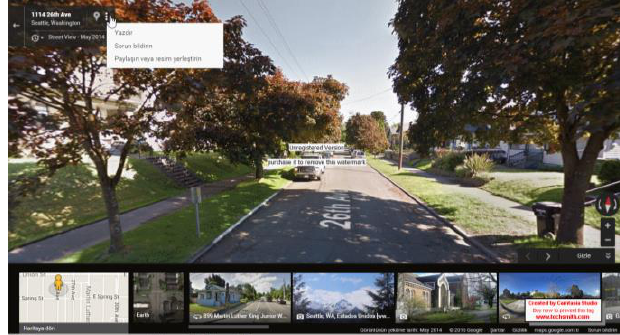
Figure 6. Google maps street view.